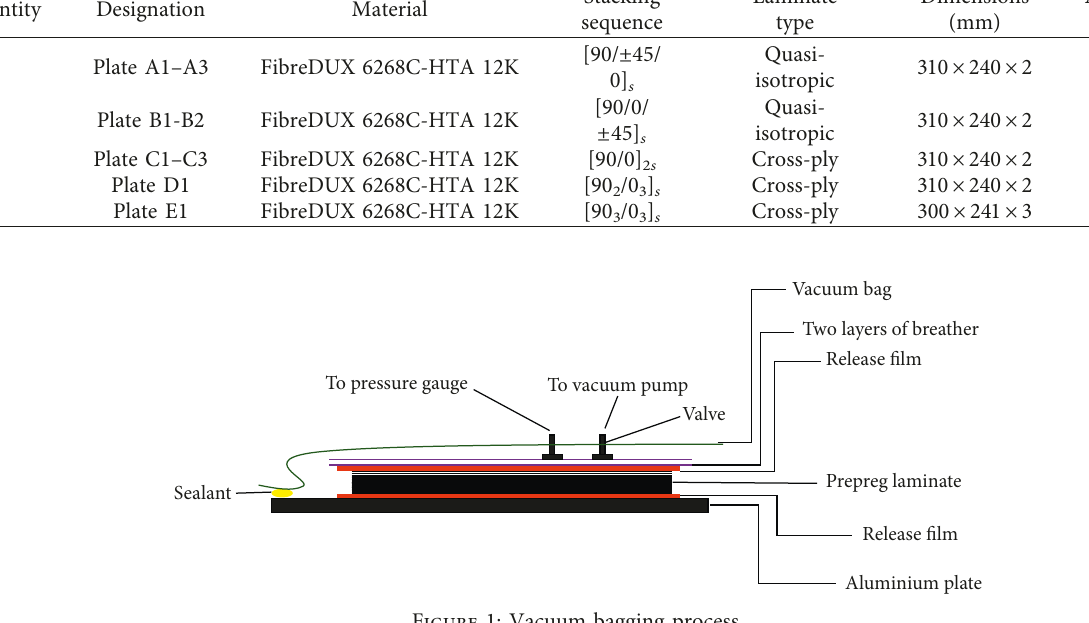
Figure 1: Vacuum bagging process.